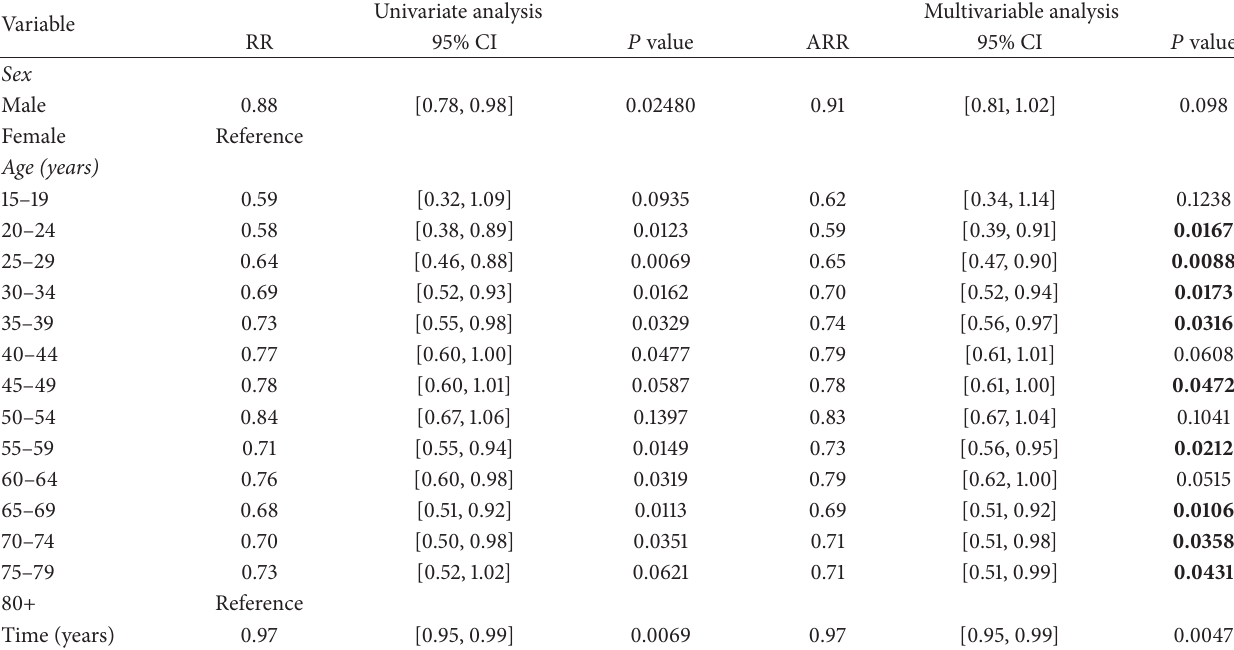
Table 5: Crude and adjusted relative risk of rectal cancer among CRC